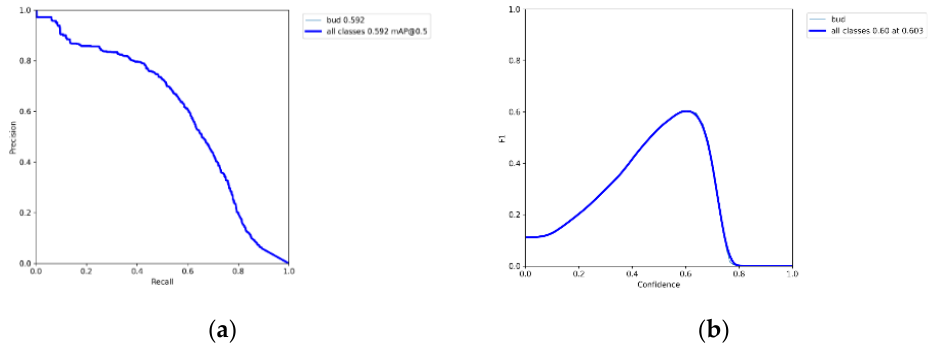
Figure A10. The changes of recall of YOLOV5l.